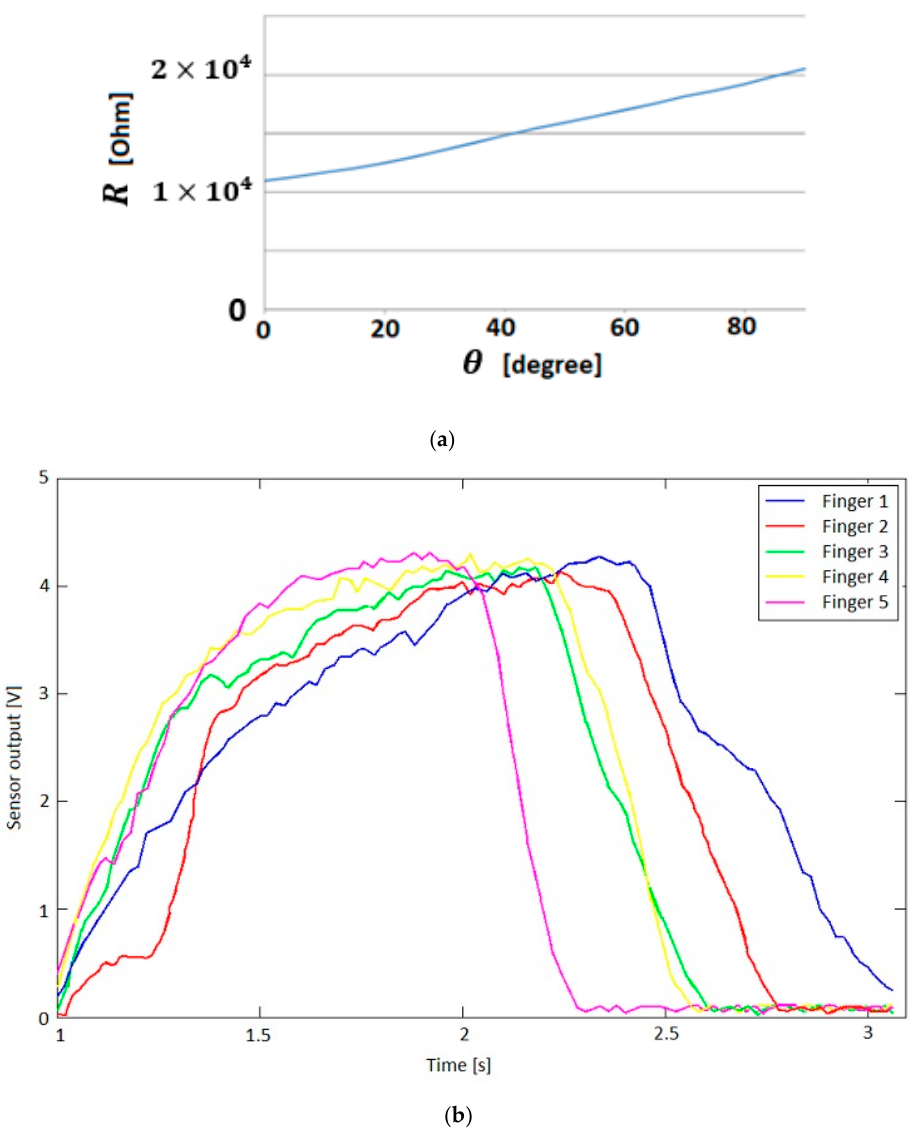
Figure 13. ( a ) Bending sensor characteristics; ( b ) Output values of the bending sensors.